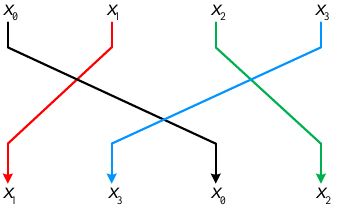
Figure 5. The process of branch